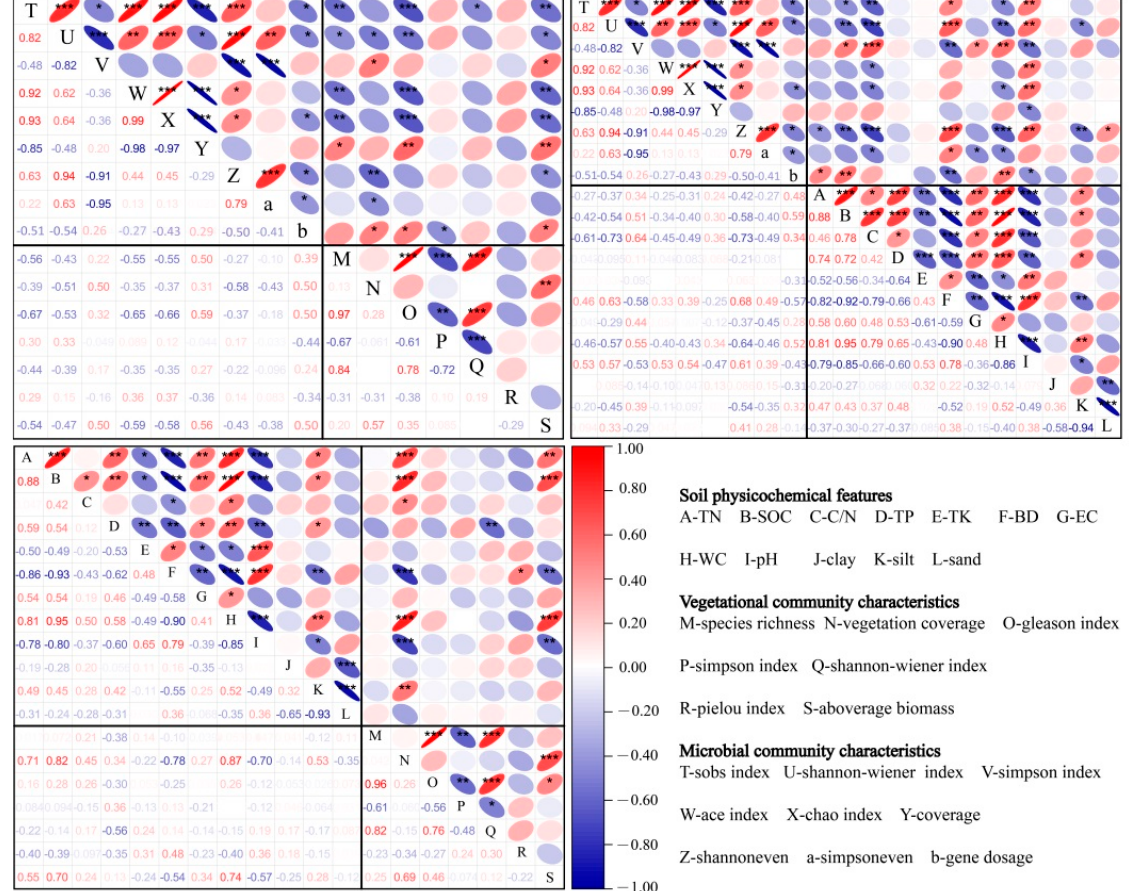
was applied to explore the relationships between environmental matrixes and bacterial communities at the phylum and genus level (Table 3). Soil physicochemical features are significantly associated with bacterial community composition across all samples. In contrast, bacterial community distance is not significantly correlated with vegetation community characteristics, topographic factors, and the combination of vegetation community characteristics and topographic factors when soil physicochemical features are used as a control based on Weighted UniFrac distance. Therefore, minor differences in bacterial community compositions are generally observed among pairs of samples with